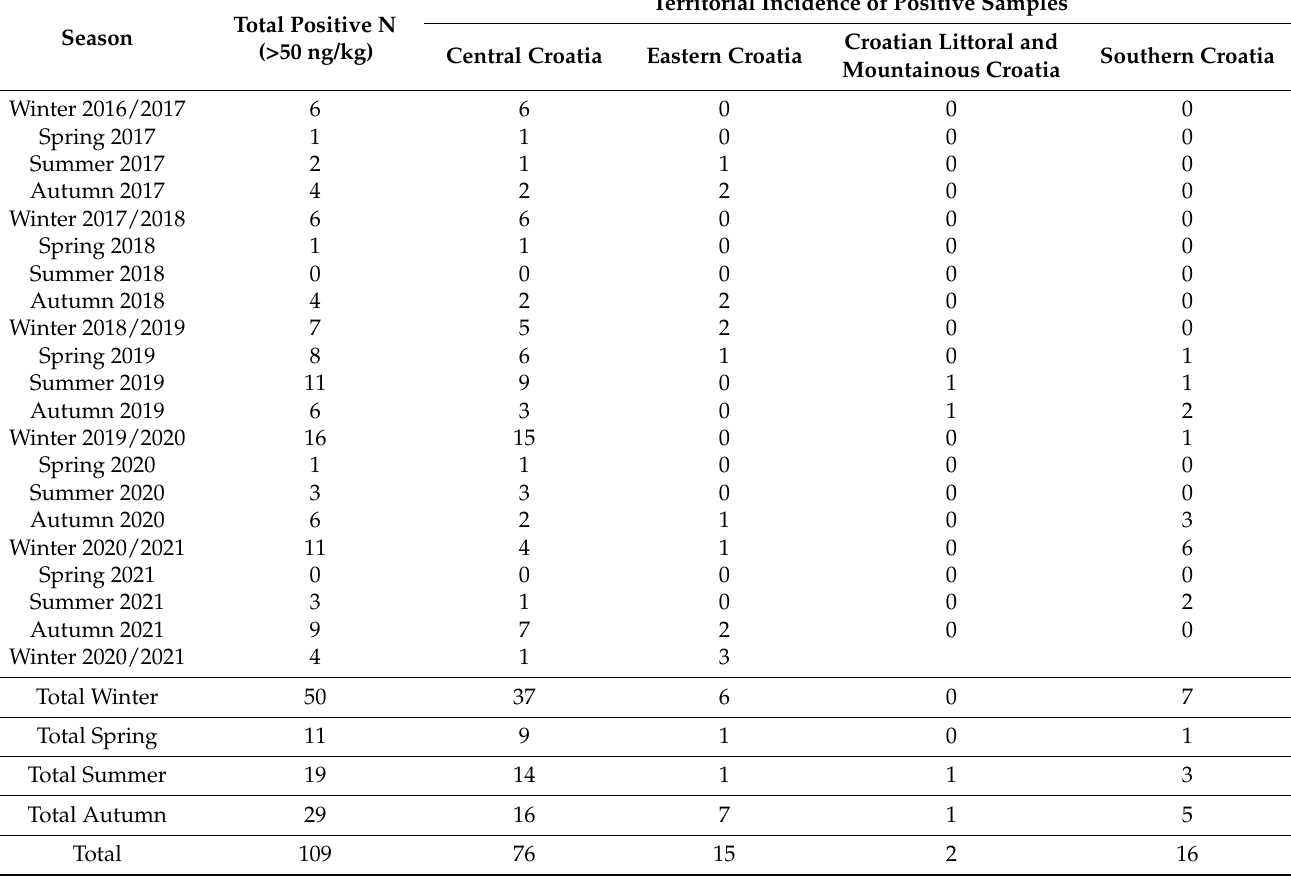
Table 3. Territorial incidence of positive raw cow milk samples collected in Croatia between winter 2016/2017 and winter